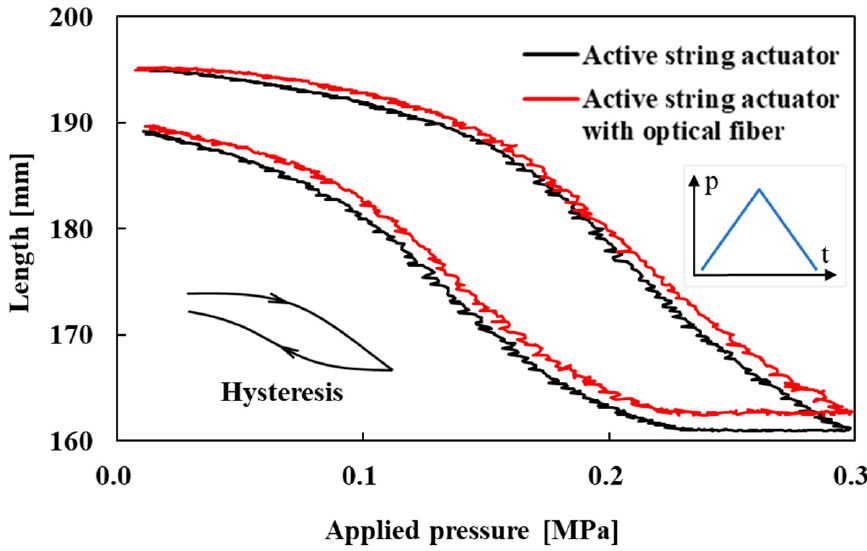
Figure 13. Contraction characteristics of the active string actuator with and without the optical fiber sensor.